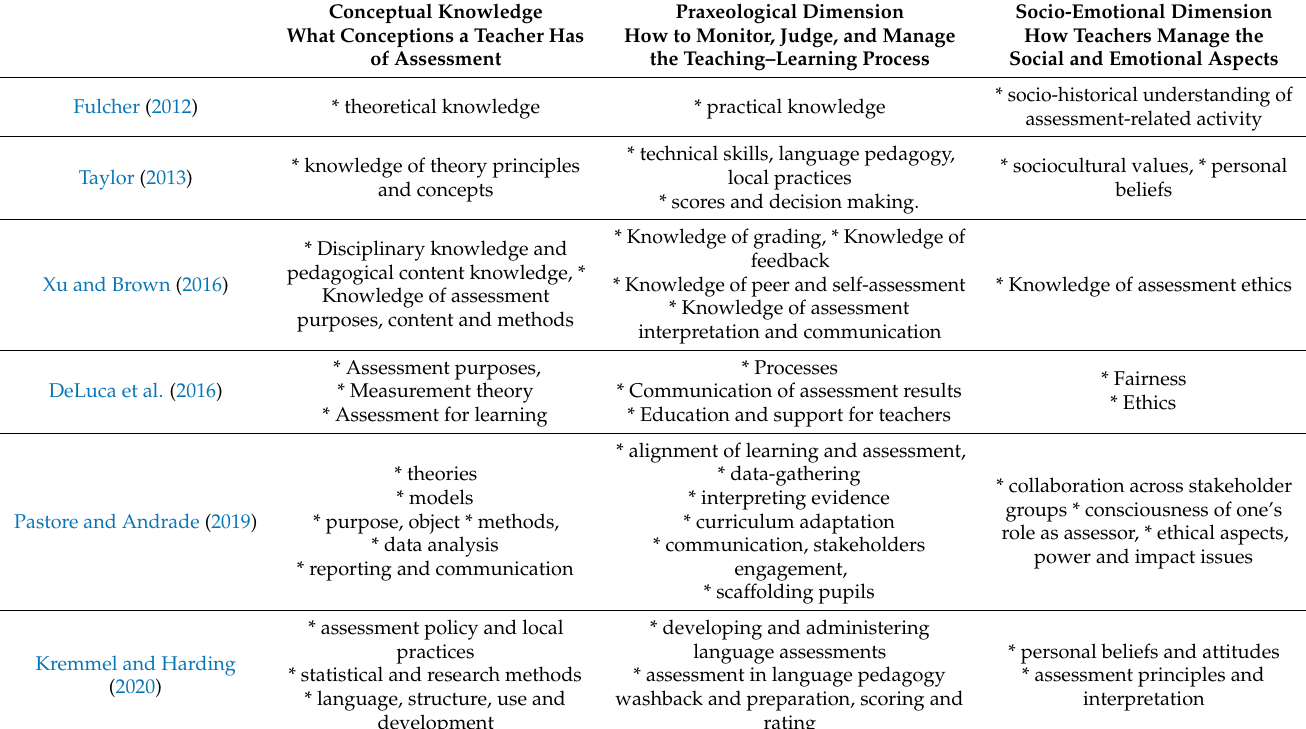
Table 1. Overview of components of language teacher assessment literacy (along dimensions based on Pastore and Andrade